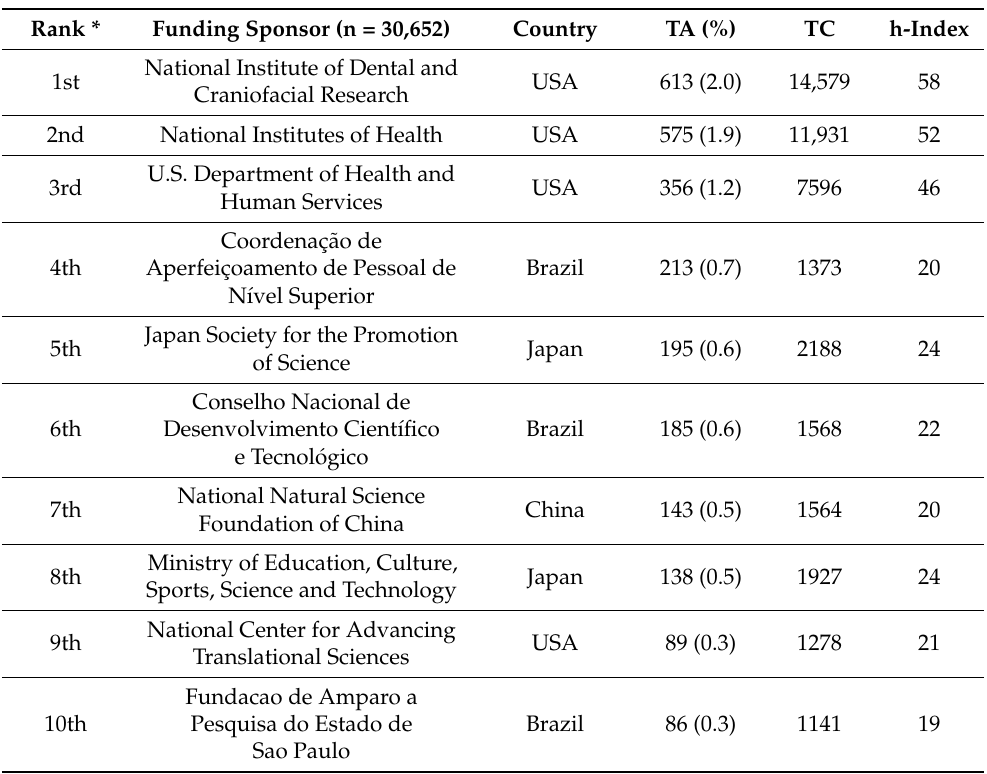
Table 6. Top ten sponsors of research on